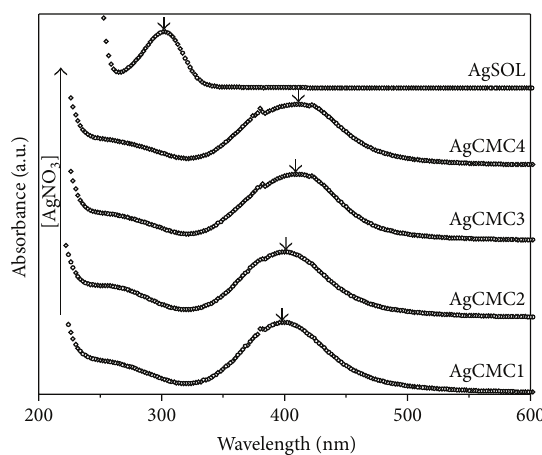
Figure 3: UV-vis spectra obtained from samples AgCMC1, AgCMC2, AgCMC3, AgCMC4, and AgSOL.